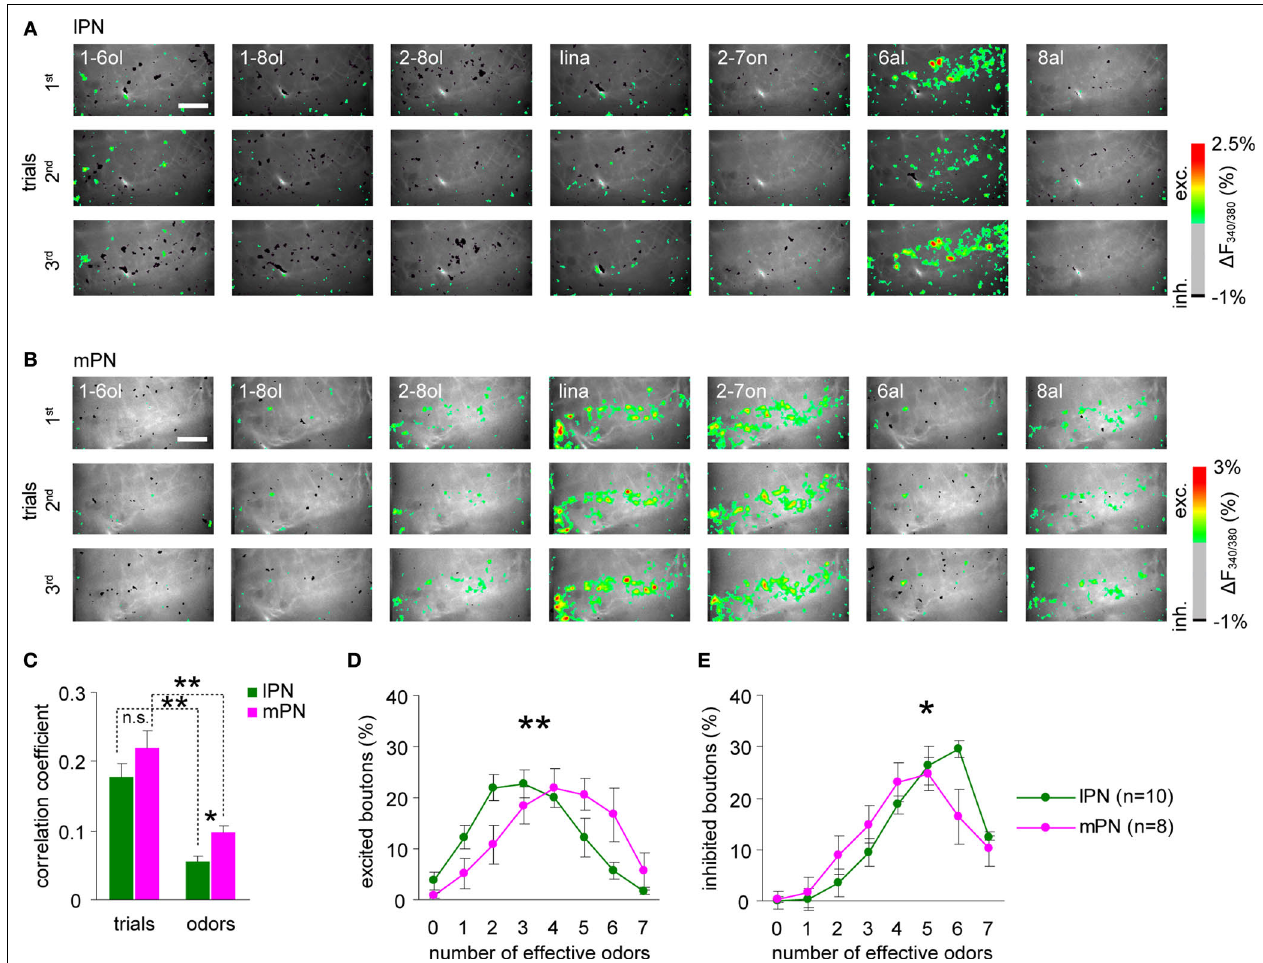
FIGURE 5 | Higher odor specifi city and sparser odor coding in lPN boutons. Representative examples of responses of l (A) and mPN boutons (B) . Variability of spatial activity patterns for seven odors (1% dilution) both in lPN and mPN bouton populations. Hexanal (6al) is particularly effective in activating lPN boutons. In general, more inhibitory responses were observed in lPN boutons. 1-6ol: 1- hexanol; 1-8ol: 1-octanol; 2-8ol: 2-octanol; lina: linalool; 2-7on: 2-heptanone; 6al: hexanal; 8al: octanal. Scale bars = 50 µm. (C) Correlation between stimulus repetitions (inter-trial) and any responses to two odors (inter-odor) in l (green) and mPN (magenta) boutons calculated separately for each bee. Inter-trial correlation of odor responses is stronger than inter-odor correlation both in lPN and mPN neurons. Inter-odor correlation of mPN boutons was signifi cantly stronger than